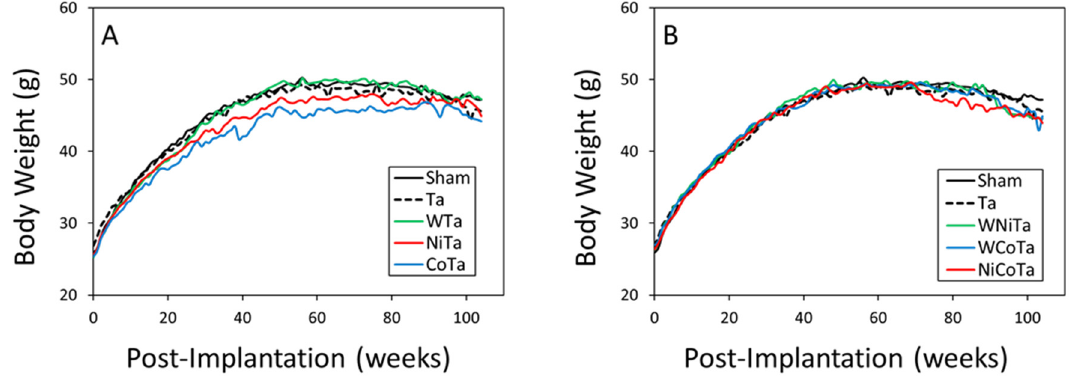
Figure 1. Body weight gain. ( A ) One-metal groups; ( B ) two-metal groups.